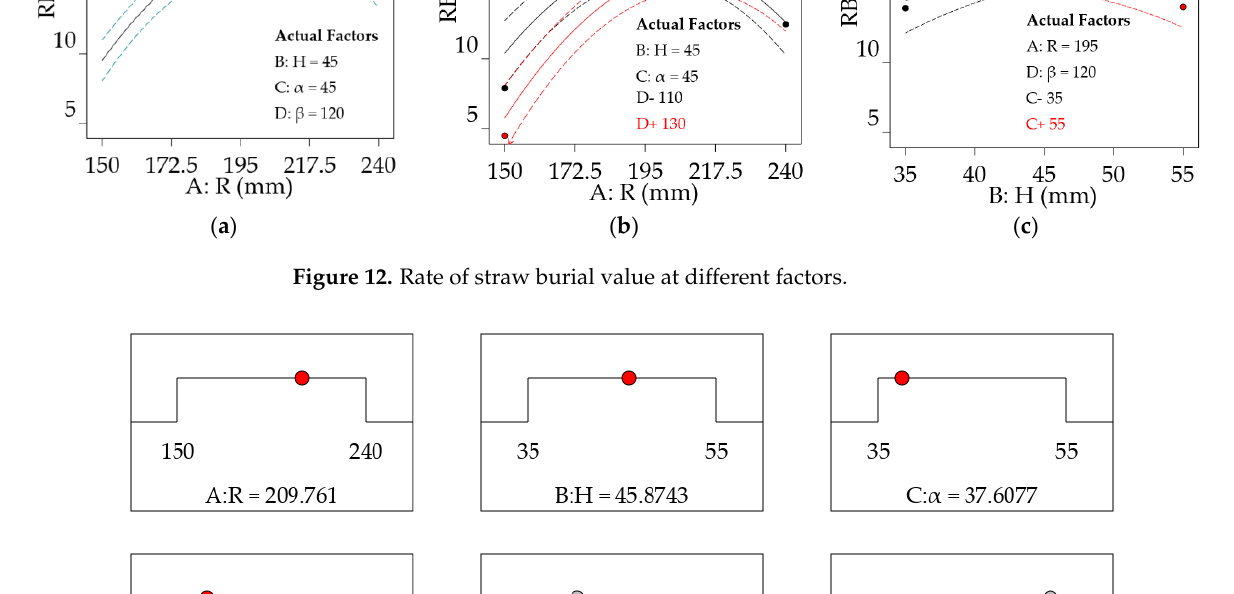
Figure 12. Rate of straw burial value at different factors.